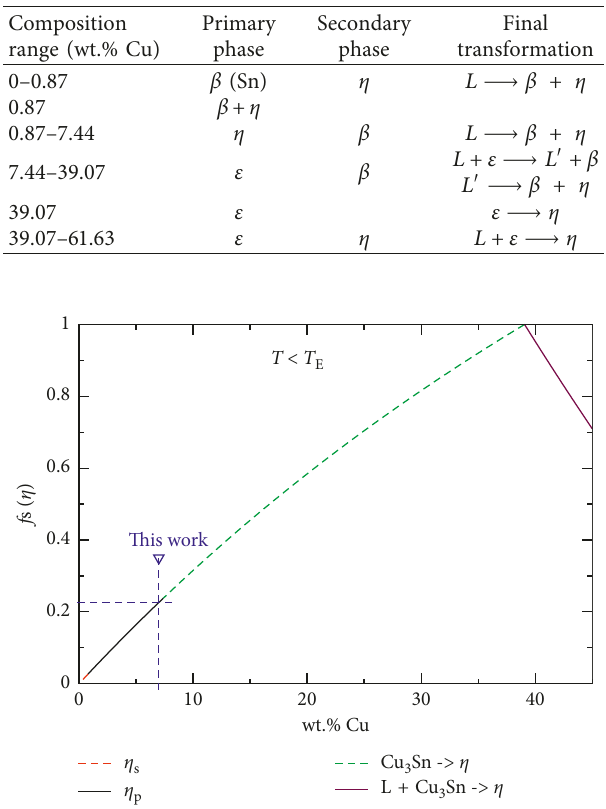
Figure 6: Origin of the η phase depending on the solidification path and composition of the alloy.